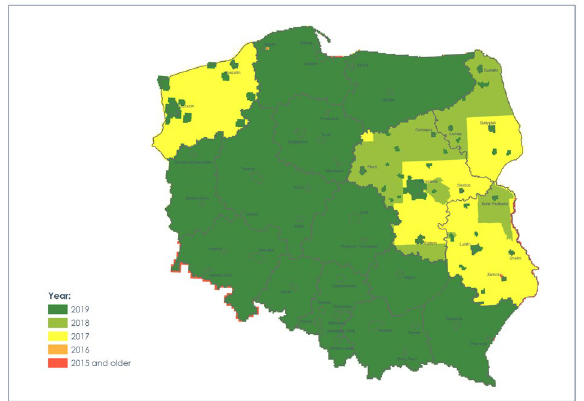
The figure 4. Planned state of orthophotomaps in national resource on the finish of 2019 year.